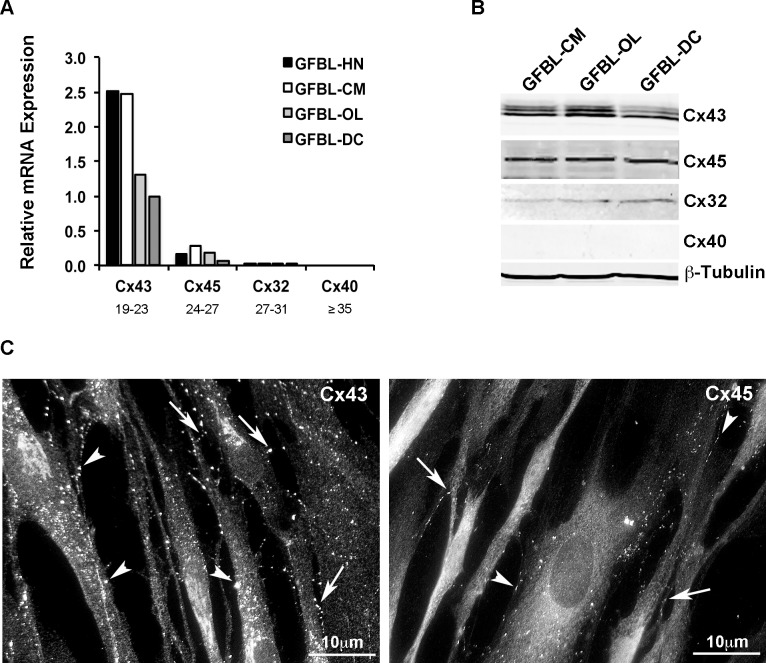
Gingival fibroblasts express C×43 as their major connexin protein.(A) Results show real-time PCR analysis of major connexins previously described in fibroblasts (C×32, C×40, C×43 and C×45) in cultured human gingival fibroblasts from four different individuals (GFBL-HN, GFBL-CM, GFBL-OL and GFBL-DC). All cell lines expressed C×43 as their major connexin, with moderate levels of C×45, low level of C×32, and no expression of C×40. Range of Ct-values obtained from real-time PCR is indicated below each gene name. (B) Similar findings were found when the same connexins were analyzed in cell lysates using Western blotting. (C) Immunostaining of a representative confluent cell culture (GFBL-DC) for C×43 and C×45. Gingival fibroblasts contained numerous C×43-positive plaques, while much fewer similar structures positive for C×45 were noted. In general, connexin-positive plaques were localized at cell-cell contact areas, possibly representing GJs (arrows), and other areas not associated with cell-cell contacts (arrowheads).